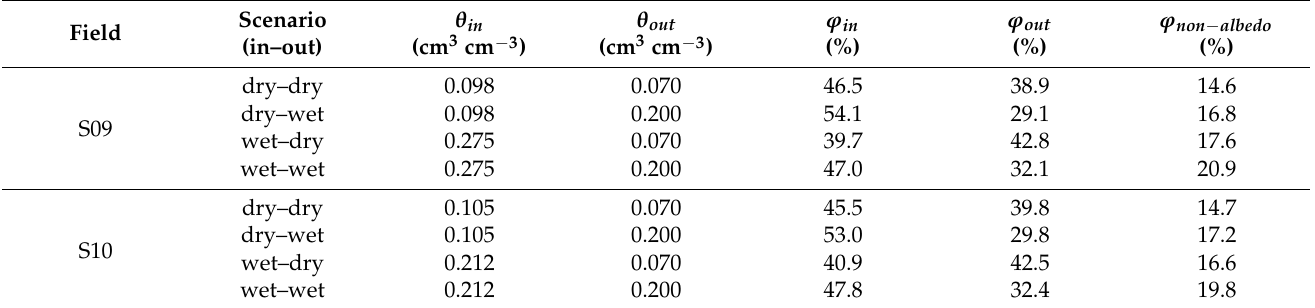
Table 2. Combinations of SM values θ in and θ out used to interrogate the existing neutron transport simulations, and the resulting subdivision of N (in%).